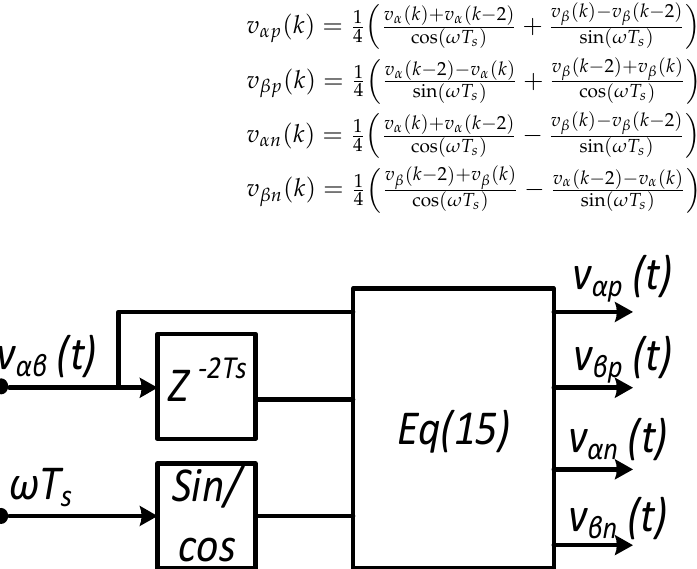
Figure 8. Sequence extraction method based on delay sample period in αβ domain .